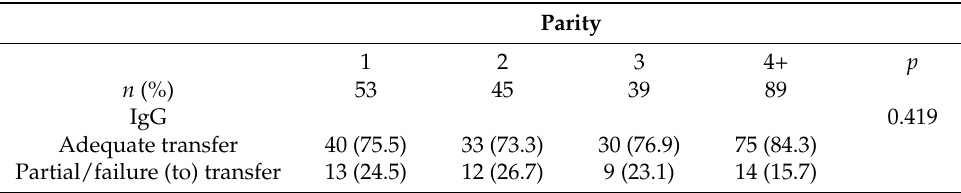
Table 10. Immunoglobulins (IgG) by dam parity in pastoral